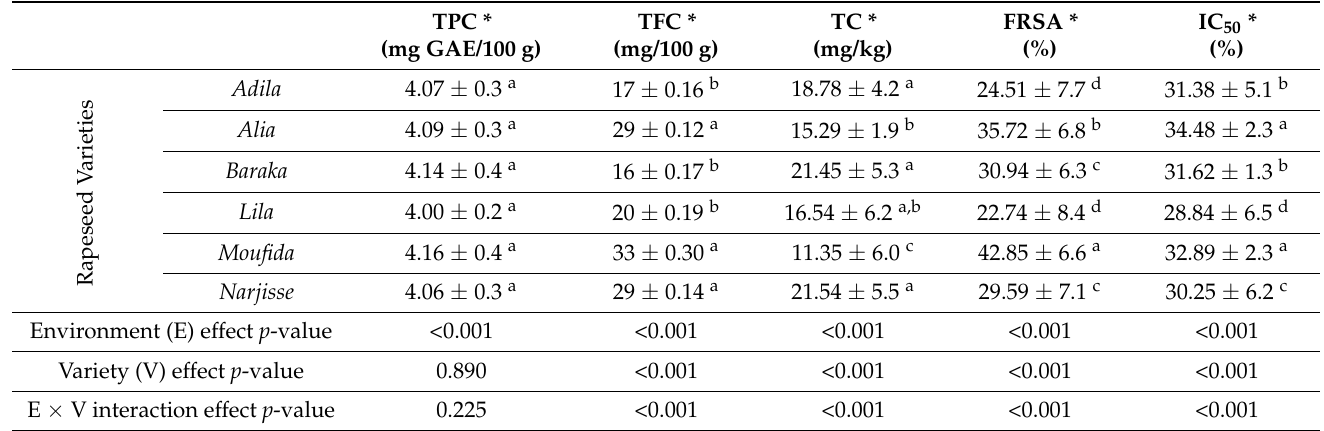
Table 3. Variation in the biochemical oil parameters of six Moroccan rapeseed varieties evaluated in two contrasting